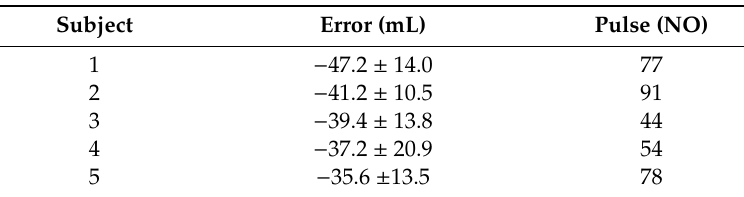
Table 5. The statistic error of SVs between the medis ® CS200 device and our ICG device using the PPG pulses with low